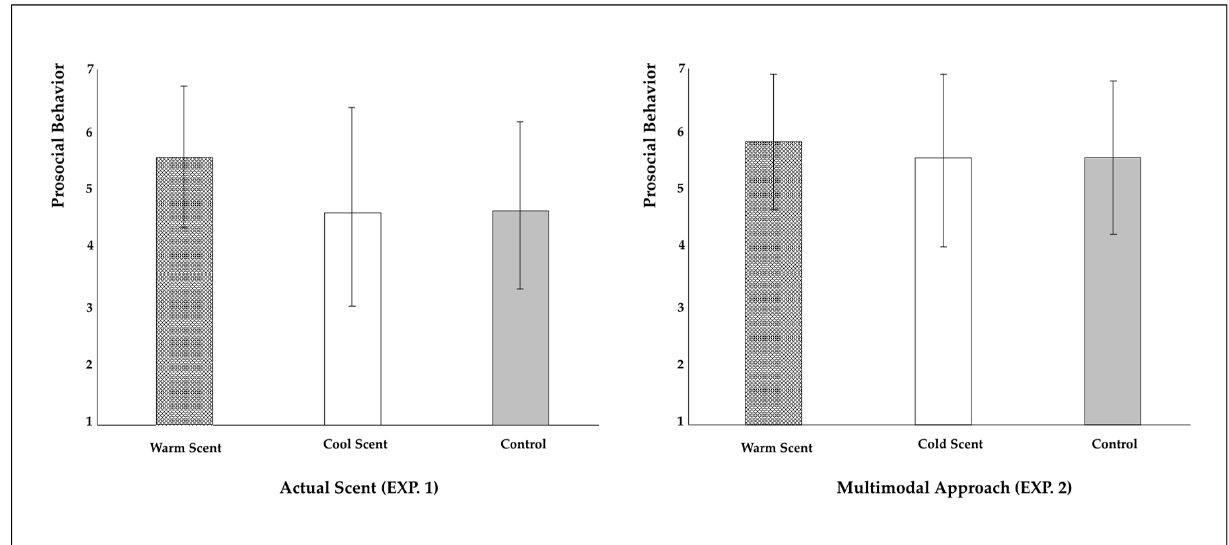
Figure 2. Results of ANOVA (EXP.1 and EXP. 2). Error bars represent one